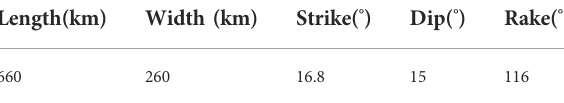
TABLE 1 Model parameters in the experiments.